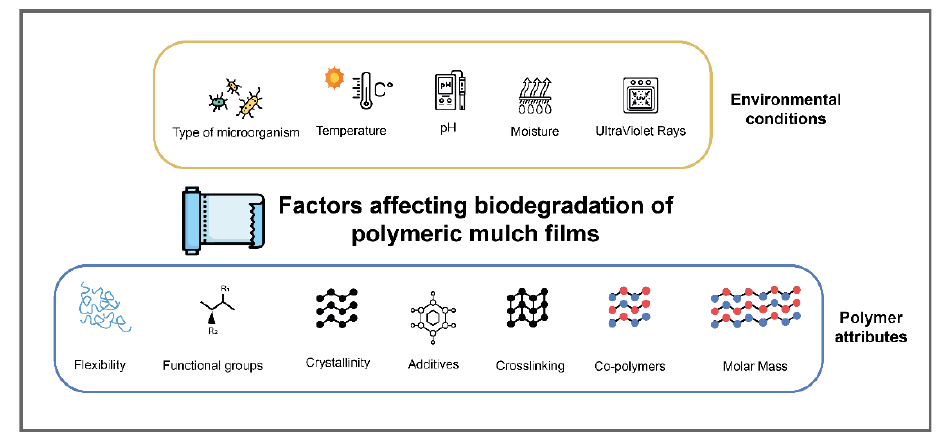
Figure 8. The factors that affect biodegradation of mulch films.